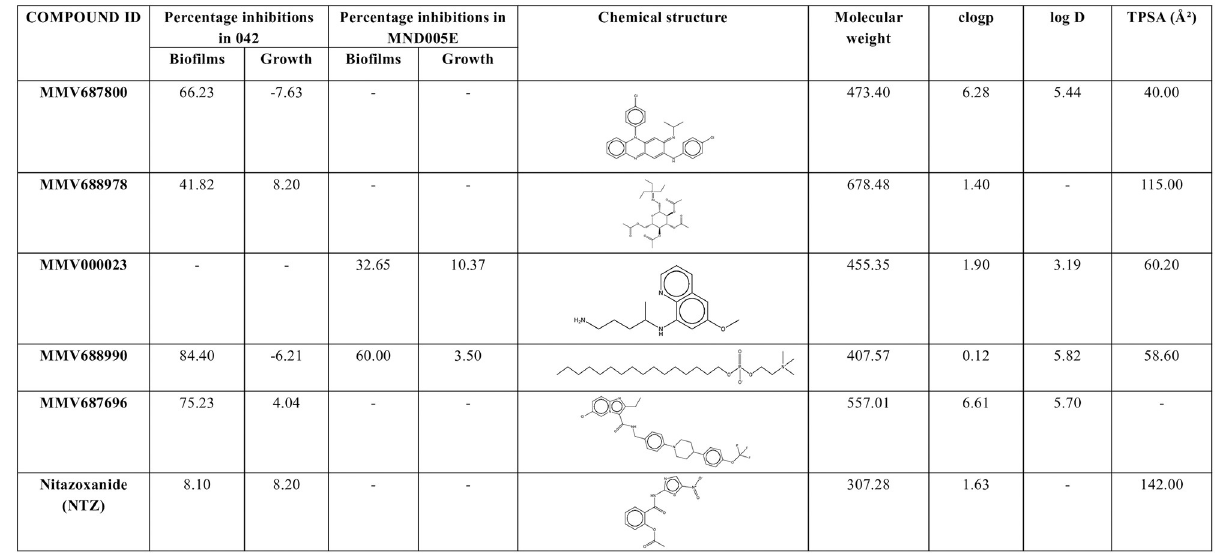
Fig 2. Chemistry of validated 042 and MND005E hits: structures, and molecular descriptors. Data provided by MMV and PubChem: At 5 μ M test concentration, all five hits outperformed NTZ with regards to biofilm inhibition in the two EAEC strains tested. Only one of the five hits (MMV688990) exhibited antibiofilm activity on the two strains tested.